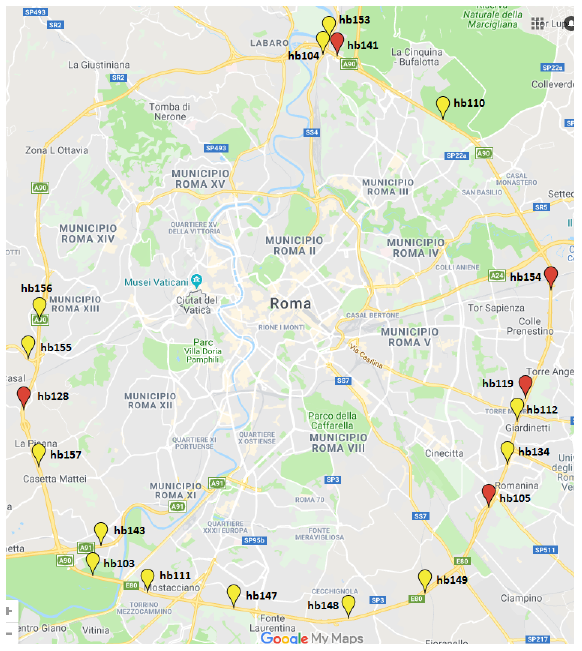
Figure 1. Map with sensors’ location information within the WASN of DYNAMAP project in the suburban area of Rome, those locations also sensed during the initial recording campaign described in [23] shown in red.